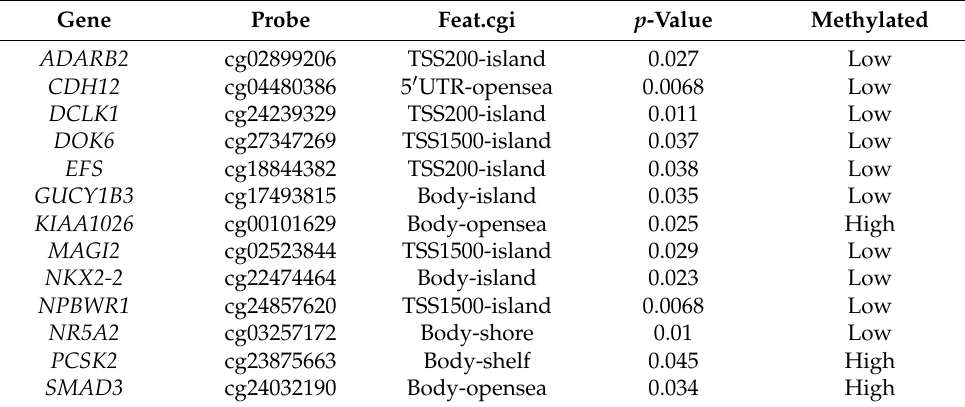
Table 2. List of the 13 CpG sites that were most highly significantly differentially methylated between individuals who survived and individuals who succumbed to CRC (high indicates hypermethylated and low indicates